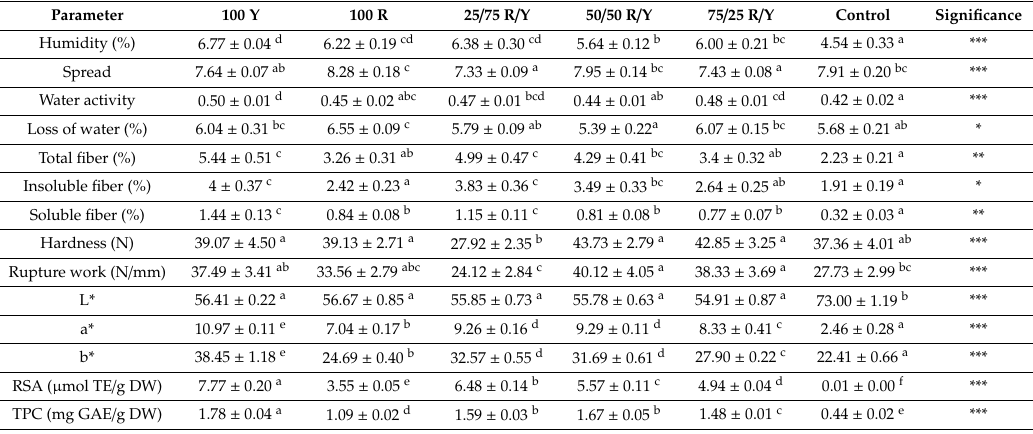
Table 5. Mean values ( ± standard error) of physico-chemical parameters evaluated on the biscuits and results of variance analysis with Duncan’s test (R-red; Y-yellow).